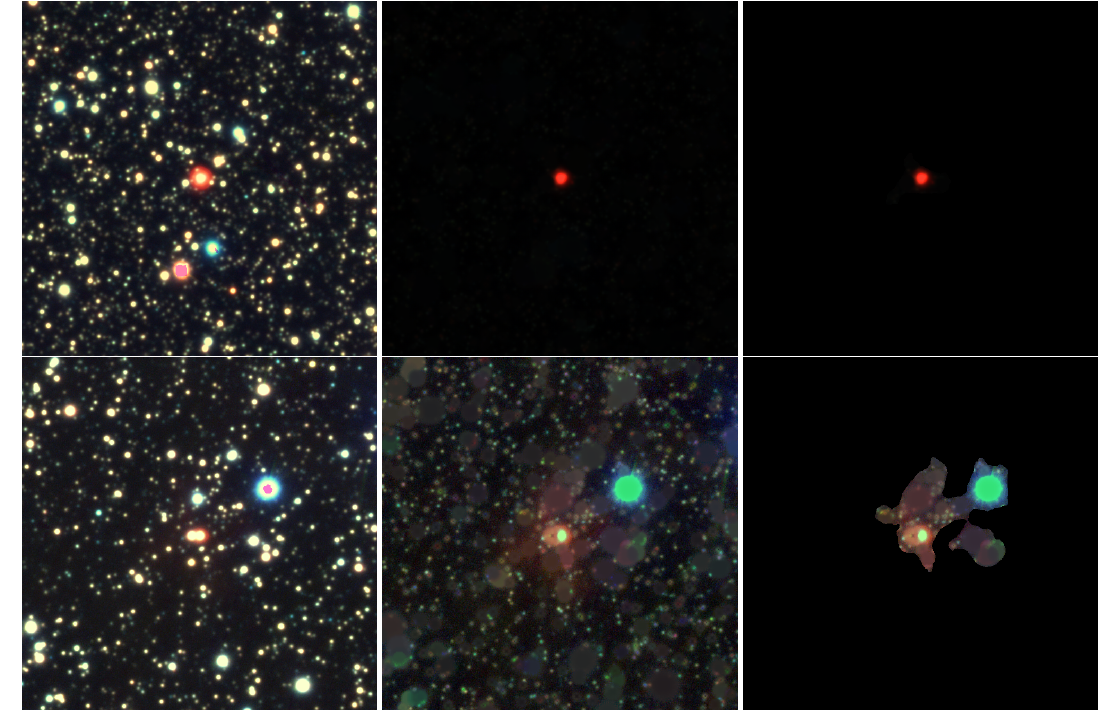
Figure 4. Examples of PNe from the Pan-STARRS survey ( left ), showing ( top ) successful and ( bottom ) unsuccessful algorithmic removal ( middle ) and masking ( right ) of contaminating stars. The bottom example shows the difficulties in isolating the faint nebular emission (the diffuse red glow in the bottom-centre panel) from the dense field of background